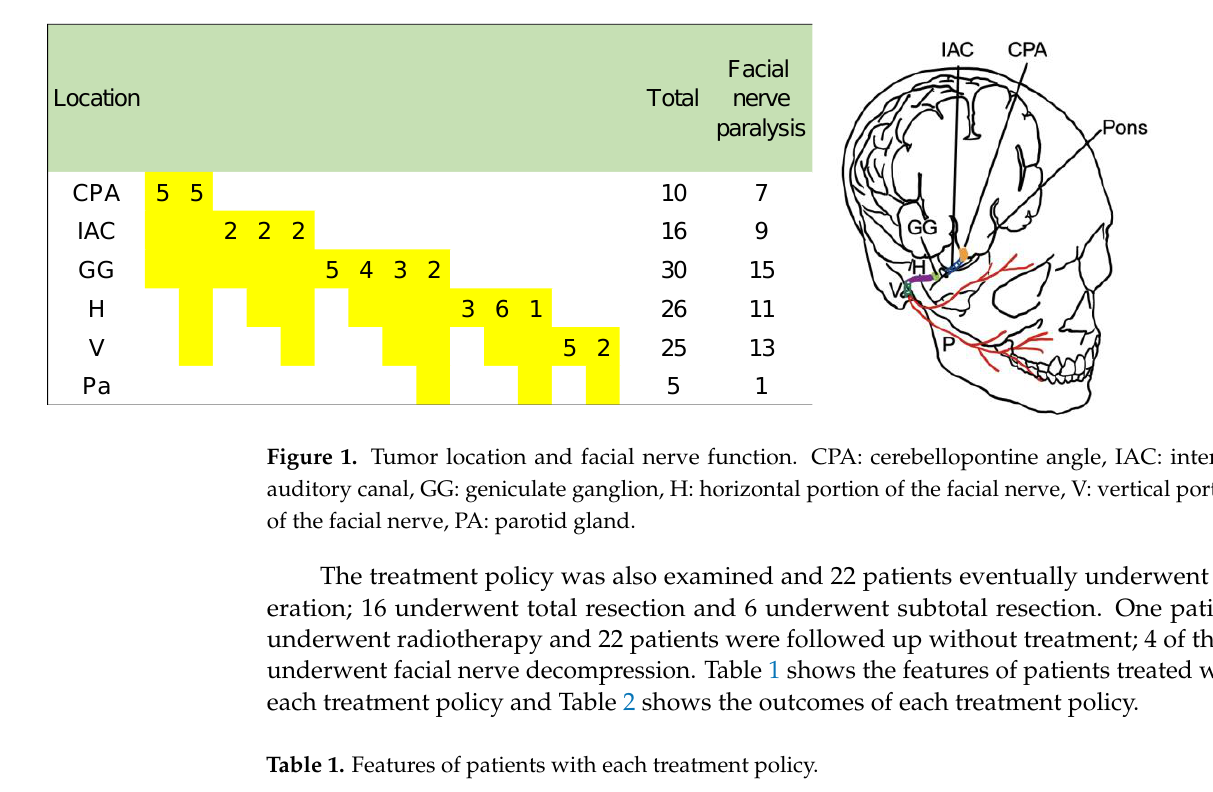
Table 1. Features of patients with each treatment